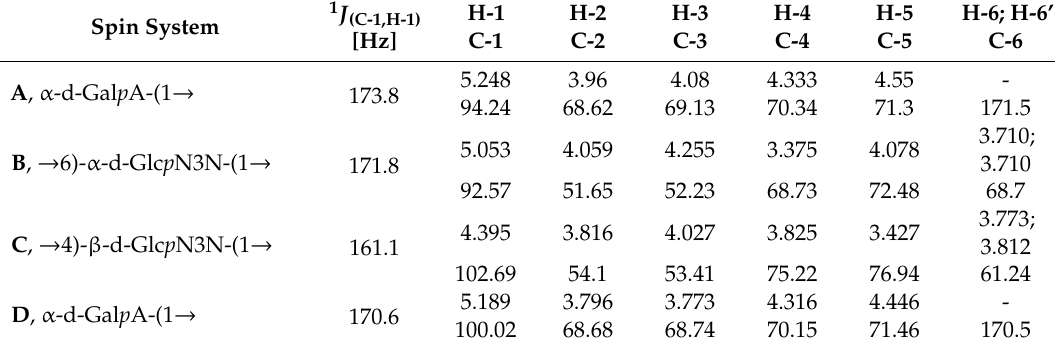
Table 2. 1 H and 13 C NMR chemical shifts [ δ ; ppm] of the O. carboxidovorans OM5 lipid A backbone.